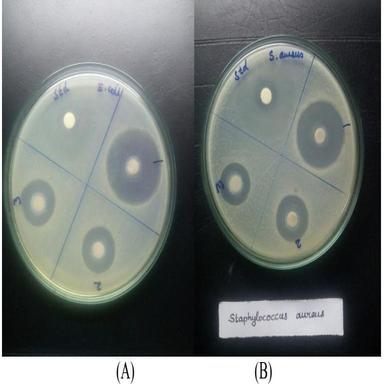
(A) Antimicrobial activity test using E.Coli, (B).Antimicrobial activity test using staphylococcus aurous